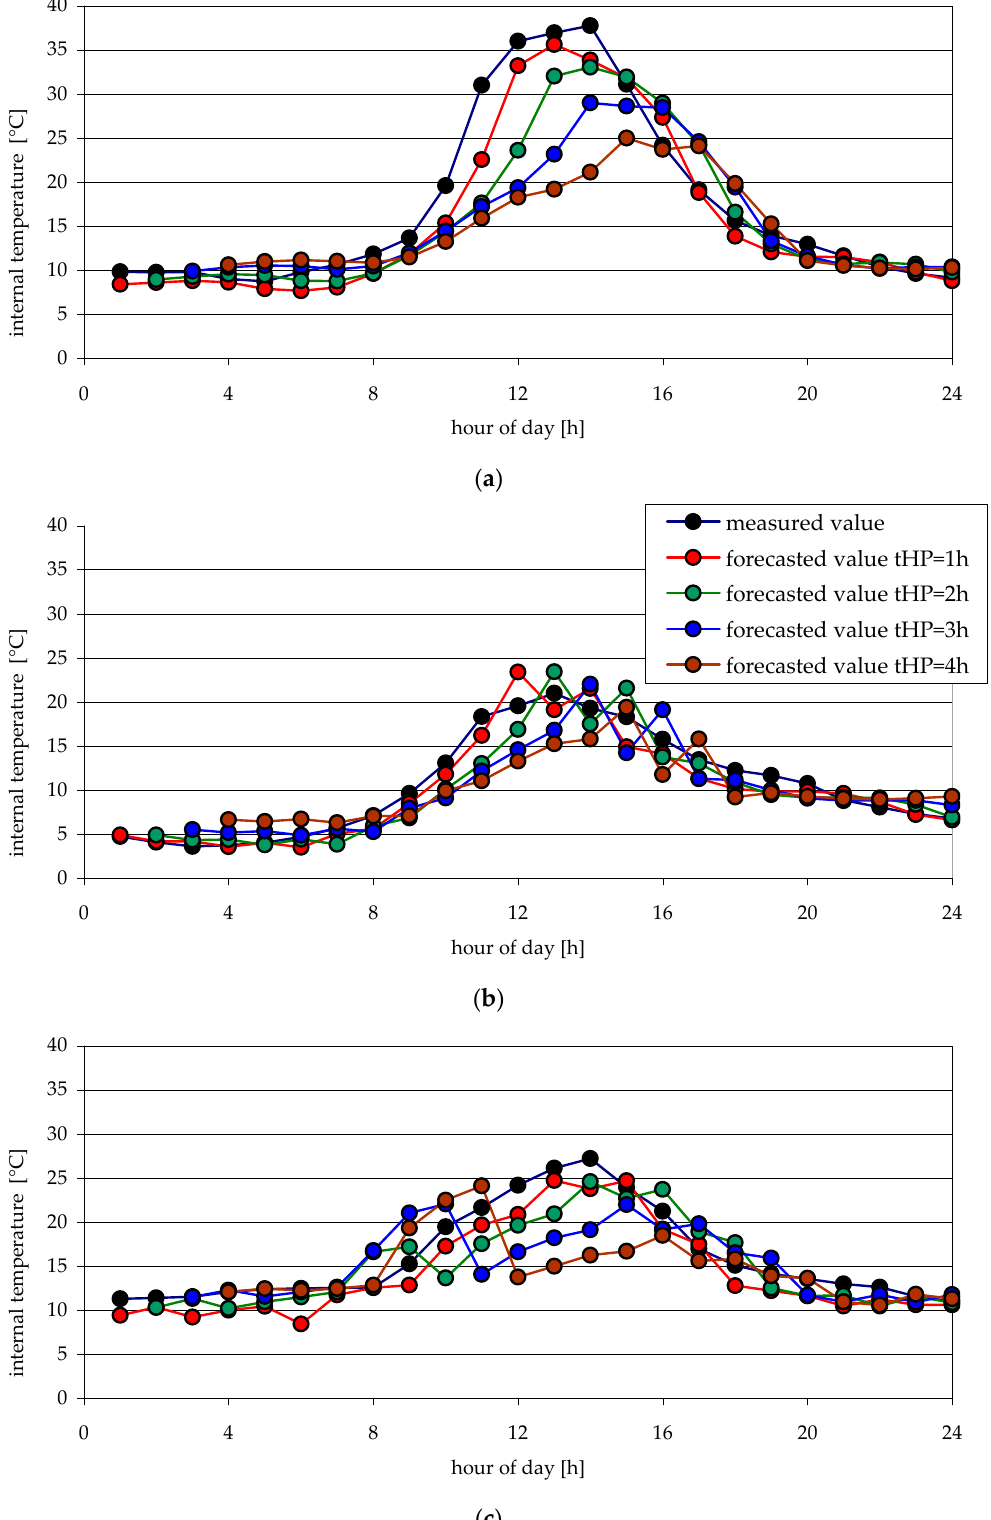
Figure 5. Forecasted and measured values of internal temperatures for selected days of October (test data) for various forecast time horizons: ( a ) 3rd October; ( b ) 14th October; ( c ) 29th October.